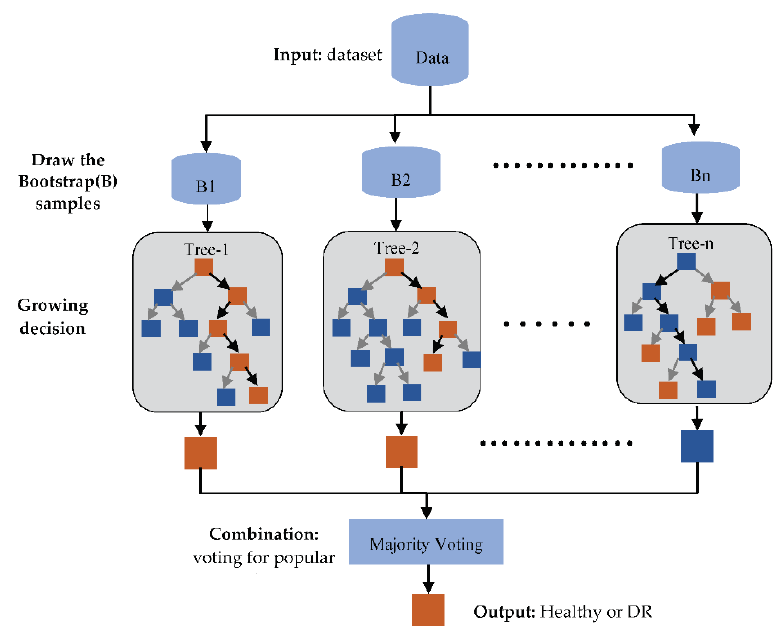
Figure 7. Flowchart of ensemble bagging classifier.